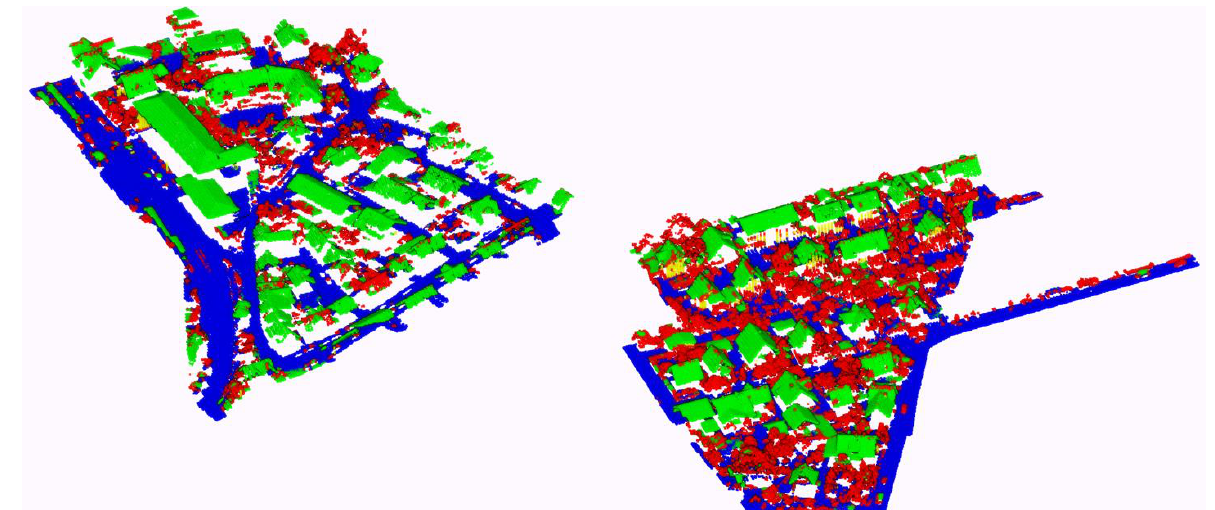
Figure 18. 4-class classification result for Vaihingen evaluation data.